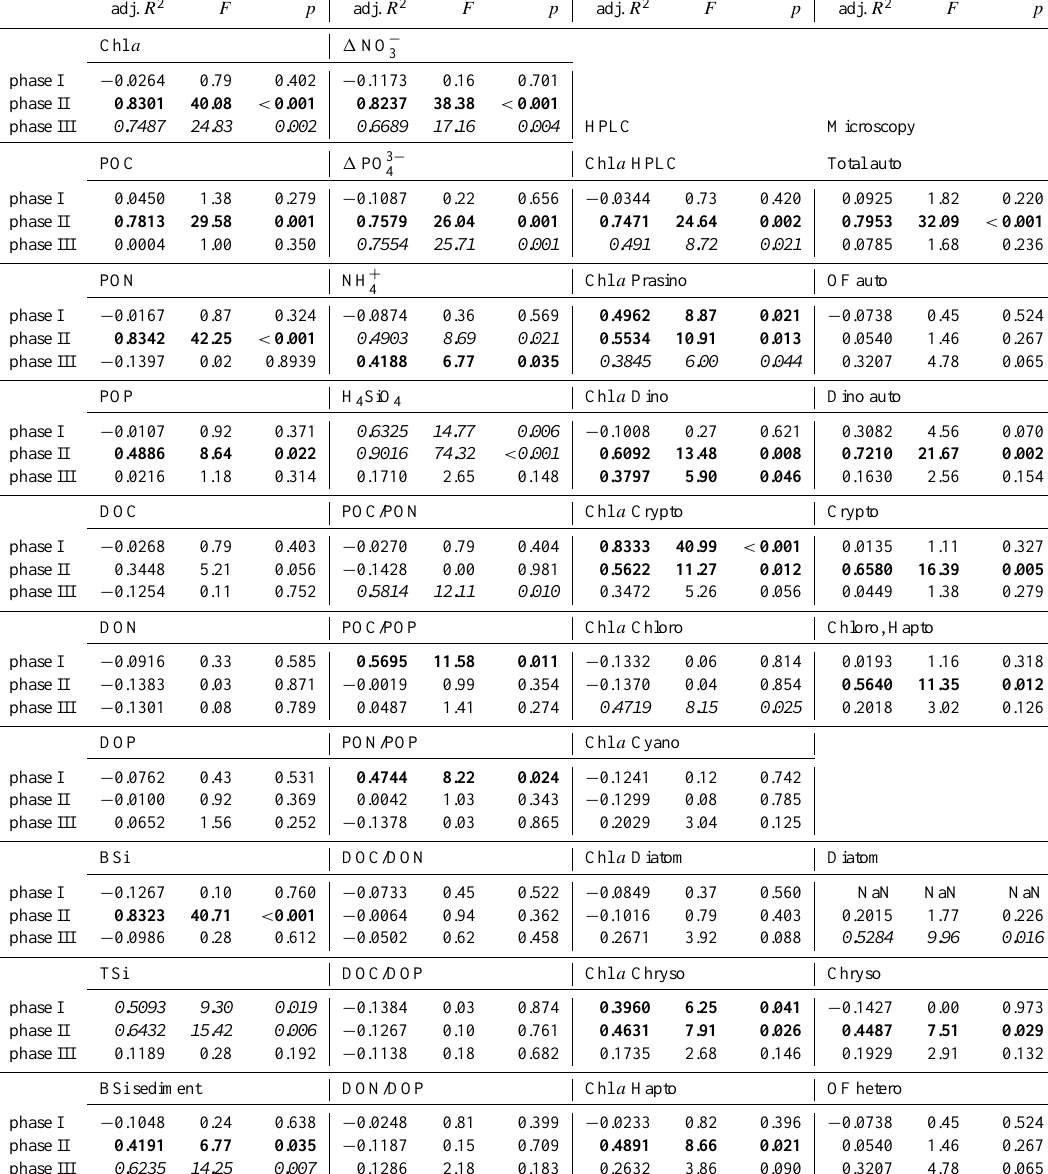
Table 2. F , p and adjusted R 2 values of F-tests on linear regressions of all measurement parameters presented in Figs. 6, 7, 8, 9, 10 and 11 in each mesocosm and respective p CO 2 during the three experimental phases. Statistically significant correlations are marked in bold for positive and italic for negative p CO 2 correlations, respectively. It is noted that at a significance level of 0.05 one would expect 5 out of 100 regressions where the true null hypothesis that there is no causal relationship with CO 2 is rejected, i.e. a CO 2 dependance is postulated where there is none. Here 43 out of 111 regressions were found to be statistically significant related to CO 2 . adj. R